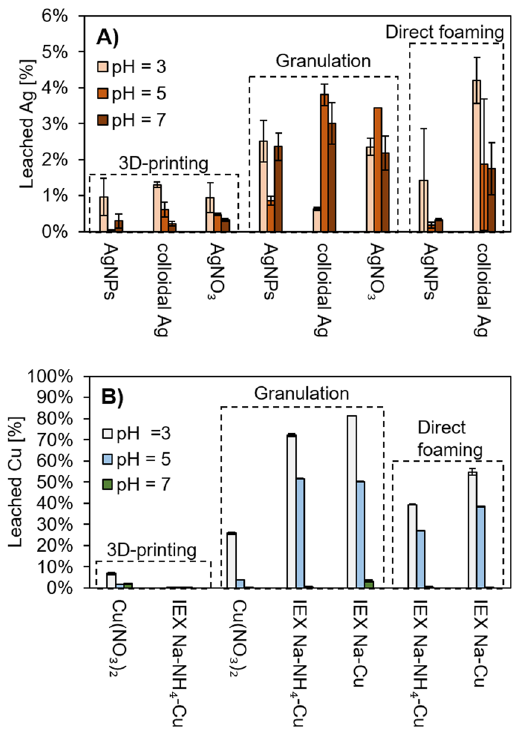
Figure 9. Batch leaching results for ( A ) Ag and ( B ) Cu at an initial pH of 3, 5, or 7 with differently prepared and modified geopolymer filters. For Ag, all ion-exchanged (IEX) materials released 100% of the metals. For Cu, 3D-printed material with Na + to Cu 2 + ion exchange released 100% of the metals. These results were excluded from the figure. Direct foaming with the addition of a metal salt was not possible due to a catalyzed decomposition of hydrogen